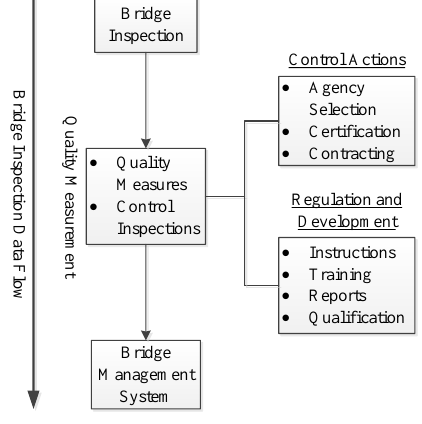
Figure 1. Data quality management in bridge inspection (Dietrich et al.,